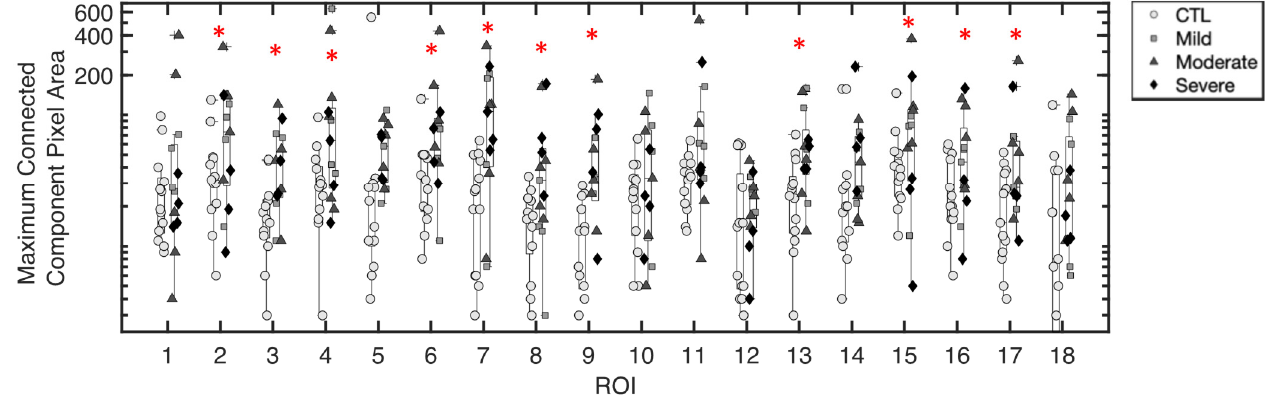
Figure 6. Maximum connected component pixel area per ROI in control and CF subjects. ROIs 1–9 are from the right lung and ROIs 10–18 are from the left lung. Red asterisks denote a statistically significant increase in CF subjects when compared to controls ( p < 0.05). Maximum connected com- ponent pixel area is plotted in log scale.